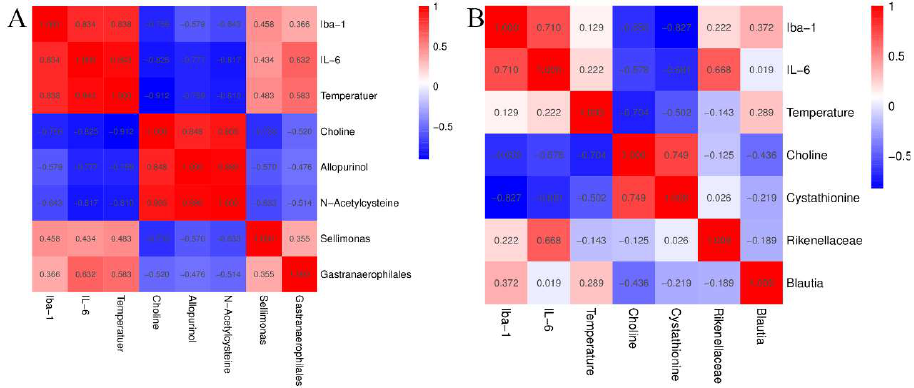
Figure 9. The correlations among inflammatory indicators, metabolic markers, and microbial markers. ( A ) The correlation of indexes between CON group and GHRS group. ( B ) The correlation of indexes between GHRS group and GHRS + REA group.